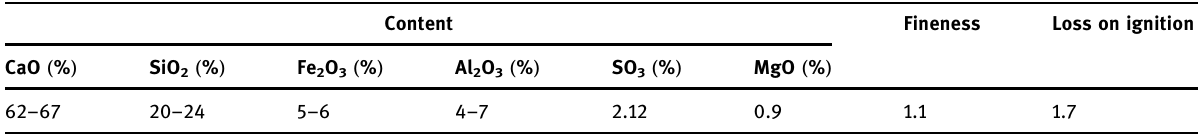
Table 1: Properties and chemical composition of